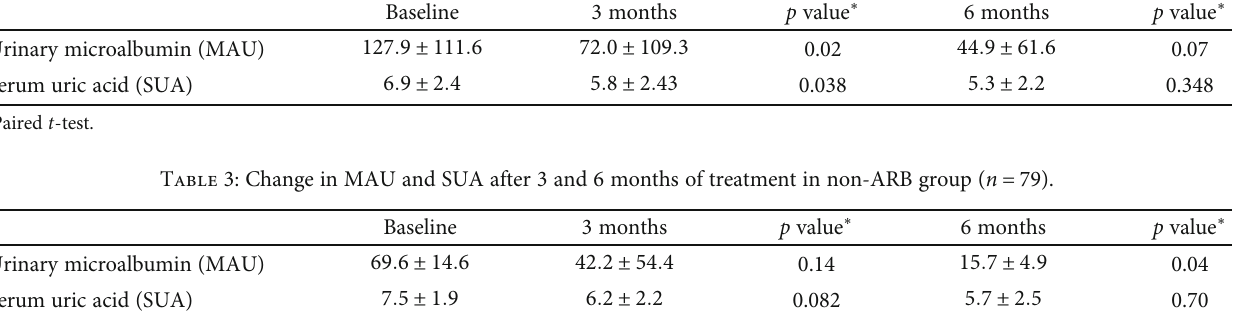
Table 2: Change in MAU and SUA after 3 and 6 months of treatment in ARB group ( n = 35 ). Baseline